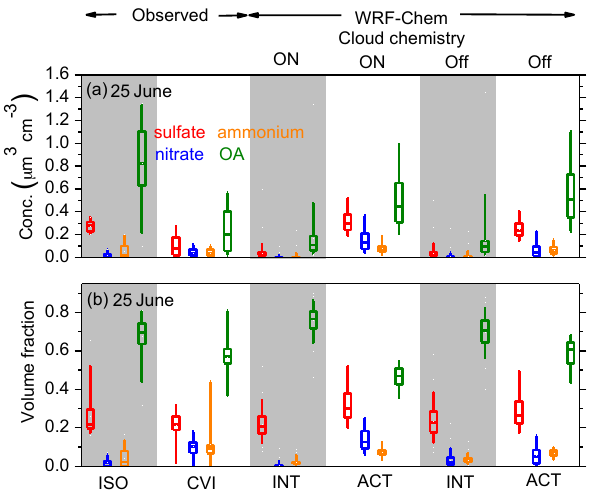
Figure 11. Aerosol mass concentration (a) and volume fraction (b) for observed interstitial (sampled via an isokinetic inlet (ISO; gray areas)) and activated (sampled via a counter-flow virtual impactor inlet (CVI; white areas)) aerosol; and simulated interstitial (INT; gray areas) and activated (ACT; white areas) aerosol at 20:00UTC on 25 July 2007. Colors indicate sulfate (red), ammonium (orange), nitrate (blue), and organic aerosol (green) in size bins 1 through 4. Box-and-whisker plots indicate the 90th, 75th, 50th, 25th, and 10th percentiles.